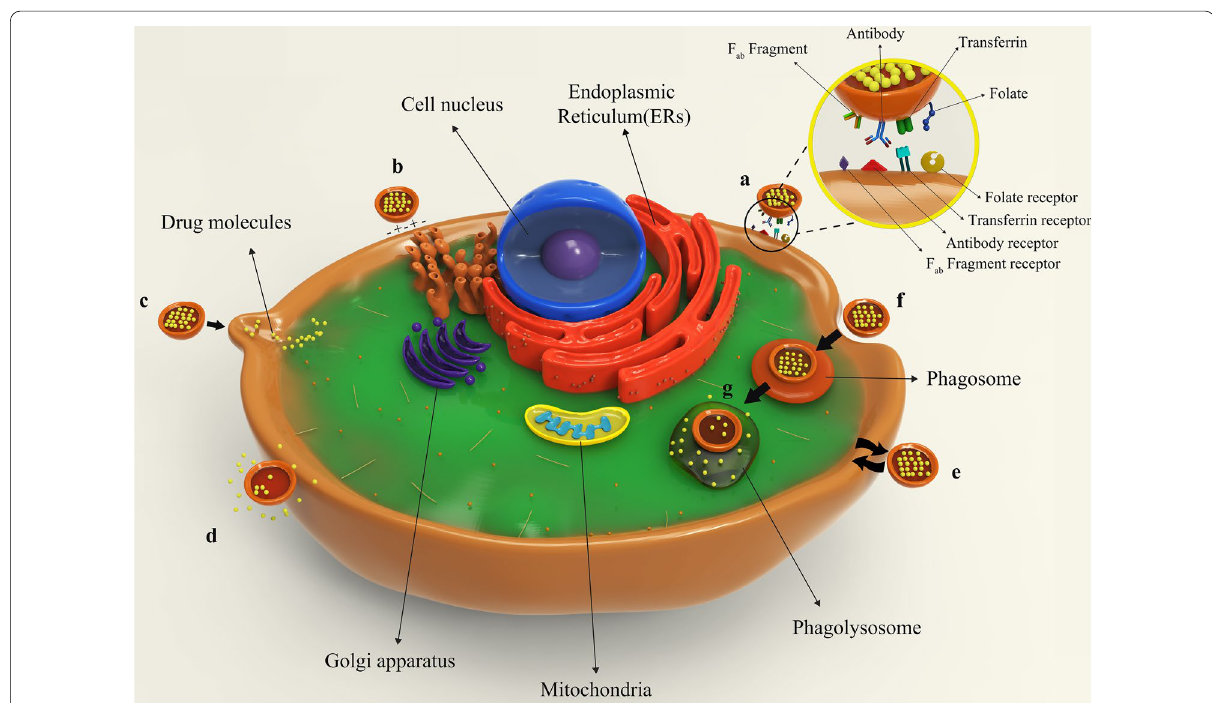
Fig. 8 Binding of liposomes to the target cell. a Specific attachment via ligand-receptor interaction; b non-specific absorption of liposomes through intramolecular-electrostatic forces; c the attachment and fusion of liposome to the cell membrane and drug release; d liposome arrival to the target cell and drug release without fusion; e exchange lipid fragments between the cell membrane and liposome through protein-mediated processes; f endocytosis of liposome by target cell; g lysosomal digestion of liposome in the cell